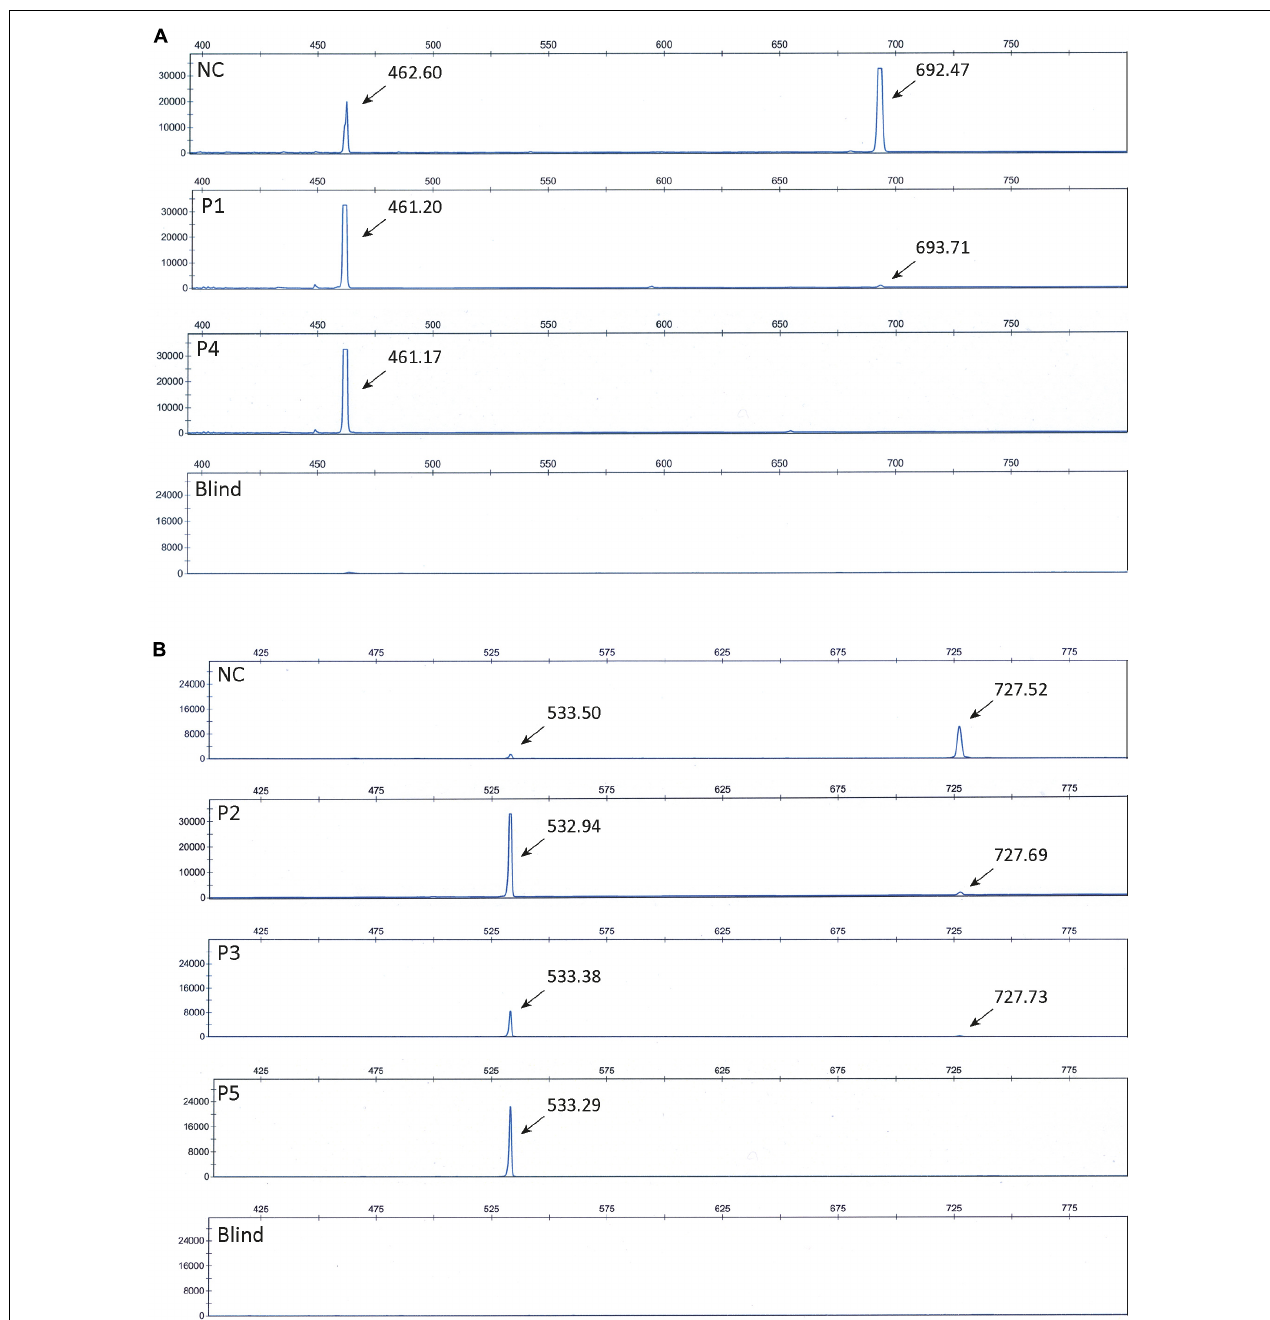
FIGURE 3 | ABI files of separated Fam-labeled PCR fragments. (A) Investigation of fragments obtained by PCR amplification of cDNA generated from P1, P4, and normal control (NC) using the primer-pair 8F and 5 (cid:48) Fam labeled 12R. Fragments representing normal spliced ATP7A mRNA (692-693 bp) and fragments representing ATP7A mRNA without exon 10 (461-462 bp) were observed as indicated. (B) Investigation of fragments obtained by PCR amplification of cDNA generated from P2, P3, P5, and normal control (NC) using the primer-pair 13F and 5’ Fam labeled 17R. Fragments representing normal spliced ATP7A mRNA (727-728 bp) and fragments representing ATP7A mRNA without exon 15 (533-534 bp) were observed as indicated. Blind represents a sample without cDNA added prior to PCR